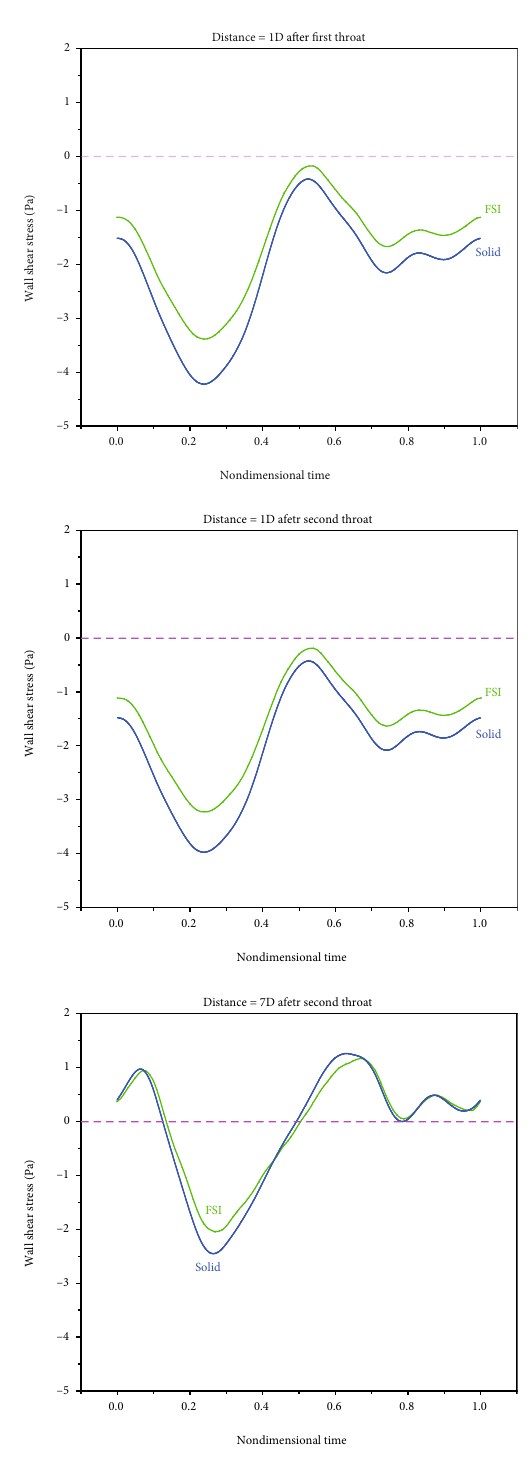
Figure 13: Comparing the WSS of the rigid and elastic walls in double